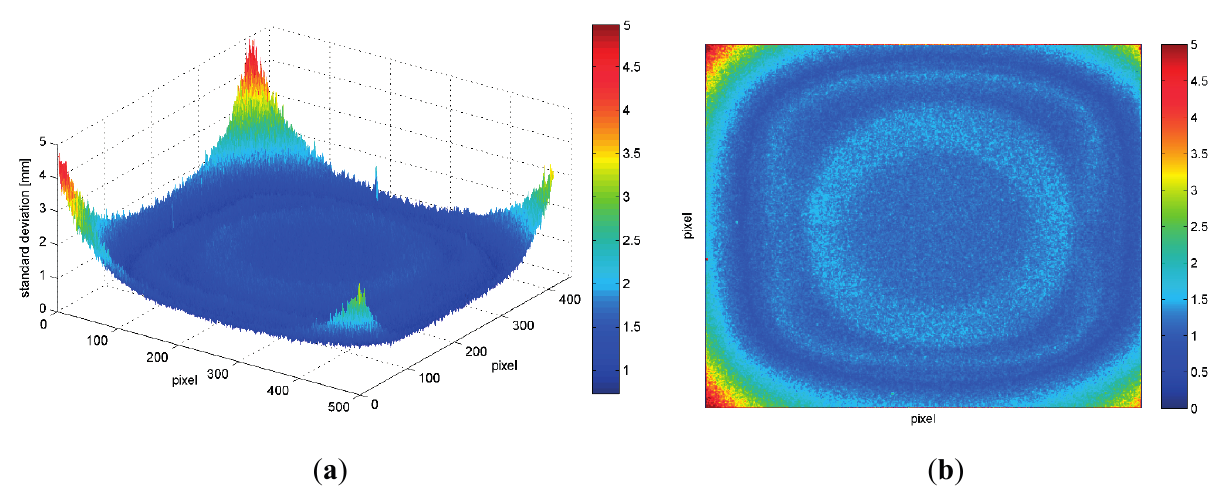
Figure 11. Standard deviations (mm) computed at each pixel from 100 acquisitions of a flat surface, acquired at a distance of 0.9 m. The sensor image plane was parallel to the object surface.